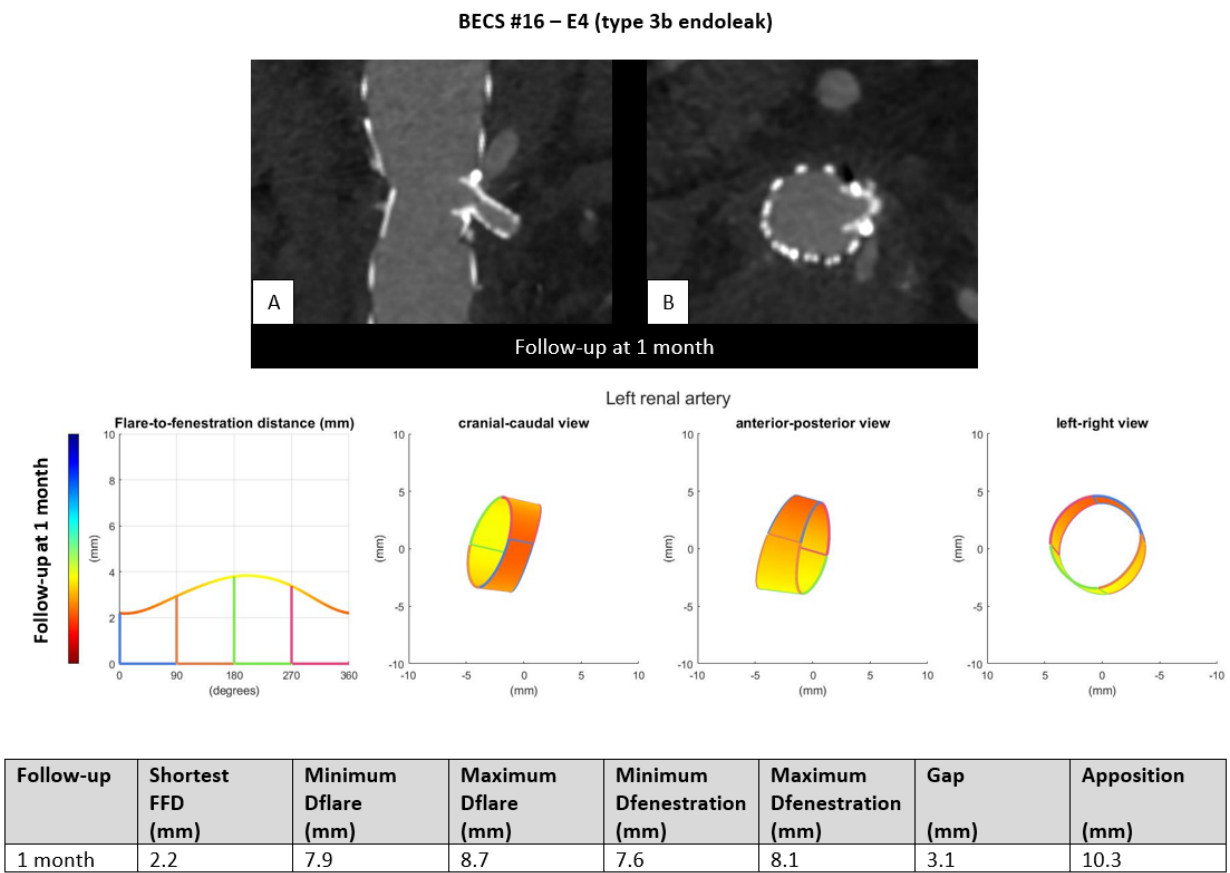
Figure 6. BECS #16 is an example of E4, endoleak due to fabric tear. The 1-month post-FEVAR CTA scan (( A ); stretched vessel view of the aorta, ( B ); axial view of aorta) showed a flared BECS in the fenestrated stent graft, and the BECS is open. Geometric analysis of the 1-month post-FEVAR CTA scan showed no other cause that may explain the endoleak.